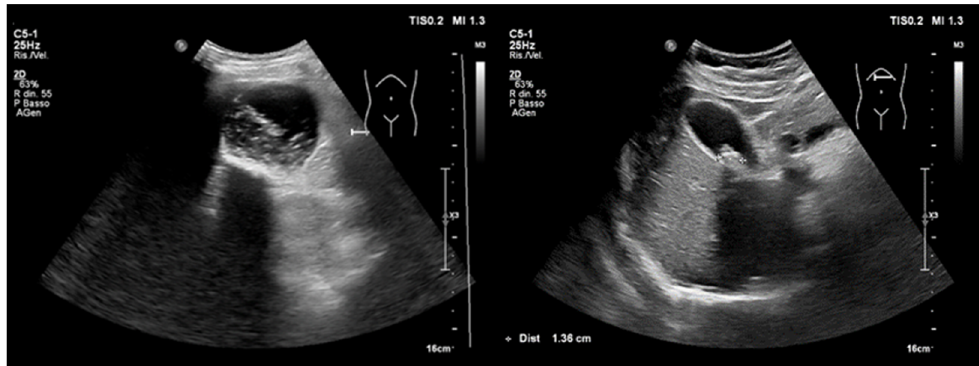
Figure 9. Ultrasonography of the right upper quadrant. A distended gallbladder with microlithiasis and large biliary sludge ( left ); multiple stones with posterior shadowing in the infundibulum ( right ).